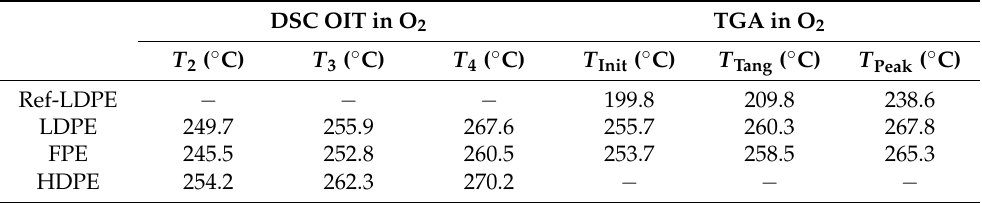
Table 1. Comparison of DSC OIT and TGA parameters of PE materials in the O 2 atmosphere.